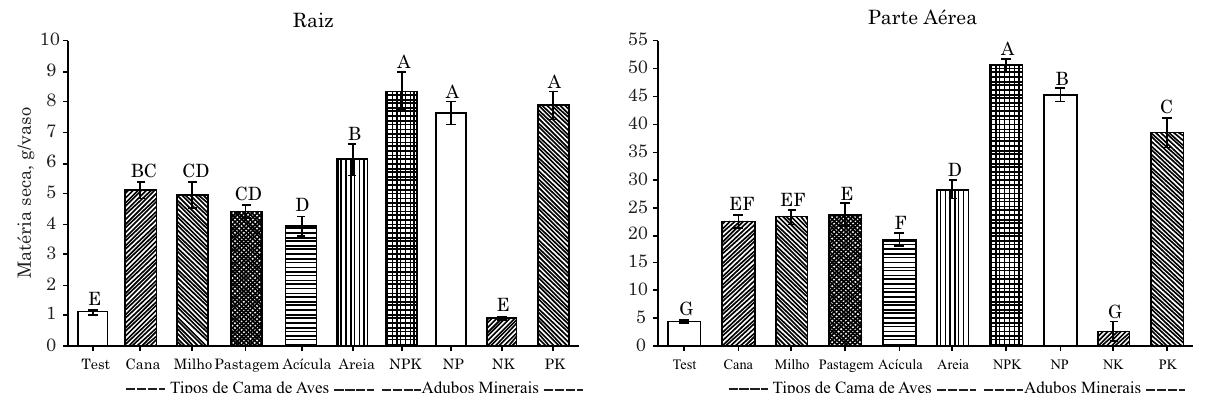
Figura 2. Matéria seca da parte aérea e da raiz de feijão, com 60 dias após a semeadura em razão da adição de fontes orgânicas e minerais, em casa de vegetação. Barras nas colunas referem-se ao erro-padrão da média. Valores nas colunas de cada época de amostragem seguidos de mesma letra não diferem significativamente pelo teste da diferença mínima significativa (DMS) a 5 %. Test: tratamento